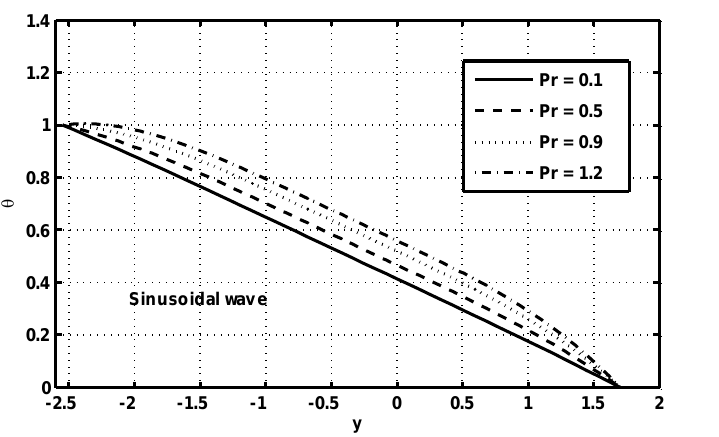
Figure 11. Temperature profile for di ff erent values of λ β = 0.0009, η = 0.009, η = 0.001, k = 0.2, M = 0.1, Pr = 1, Q = 4, Ec = 0.2, x = 1. 2 1